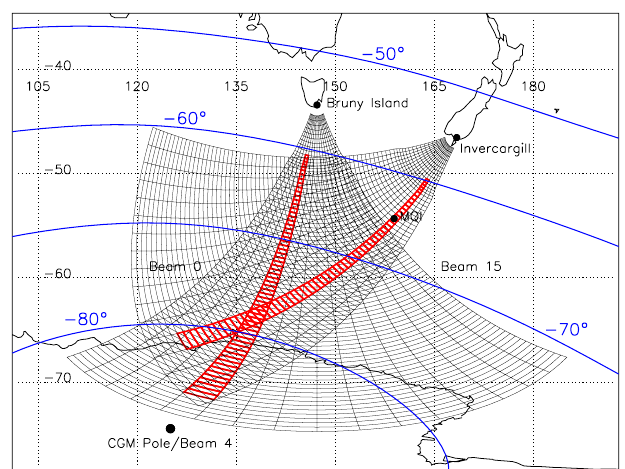
Fig. 1. The locations and overlapping fields of view of the Tasman International Geospace Environment Radar (TIGER). The camping beams and range gates used to collect 1-s time resolution data for this study are shown in red. Beam 4 of the Tasmania radar points toward the AACGM pole, whereas beam 12 of the New Zealand radar passes over Macquarie Island. AACGM latitudes are shown in